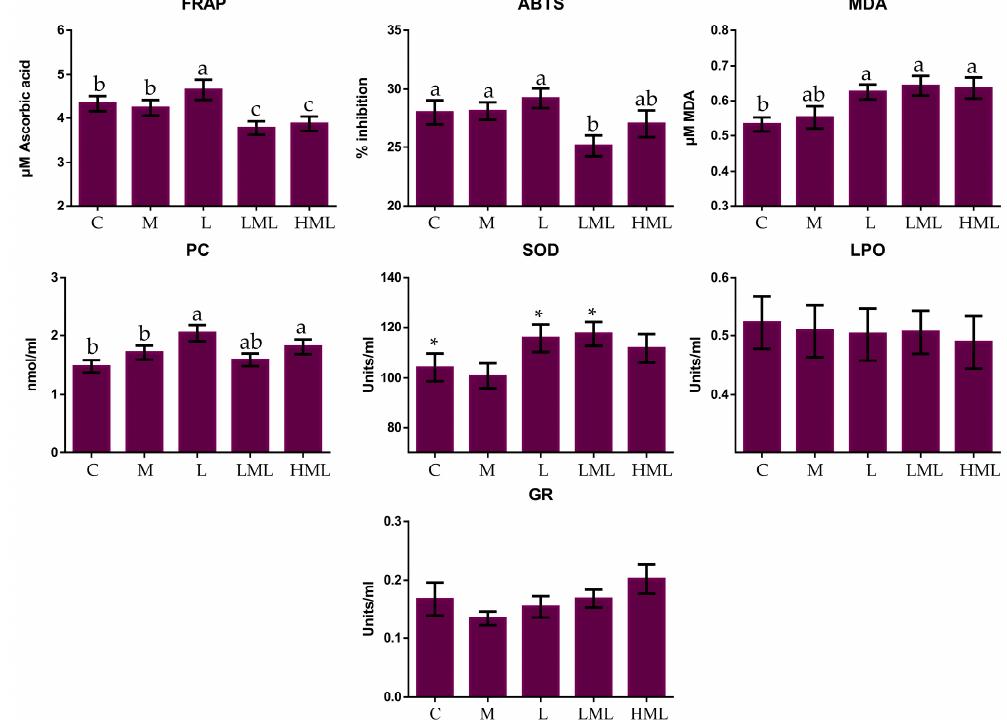
Figure 3. Means ± SEM of total antioxidant capacity, oxidative stress indicators, and enzyme activities (Units/mL), in the milk of ewes, fed the five diets (C, M, L, LML, and HML) within the three sampling times. Bars with different superscript (a, b, c) between dietary treatments differ significantly ( p ≤ 0.05), while * is referred to p -value < 0.10. In Figure 4, a Spearman correlation depicts the regression between milk and blood antioxidant indexes, energy, and nitrogen balance metabolites (b-hydroxybutyric acid and urea respectively), and energy corrected milk yield based on the results given by Tsiplakou et al. [19]. Interestingly, ECM yield was negatively correlated with blood GST, GSH-Px, and SOD activities and ABTS values, while a significant positive correlation was observed with milk ABTS values and LPO activity, as well as GR and CAT activities in blood plasma. B-HBA concentration was negatively correlated with GSH-Px activity in blood, MDA levels in milk, and PCs concentration in both milk and blood plasma. Urea in blood was negatively correlated with GR activities in both milk and blood plasma.